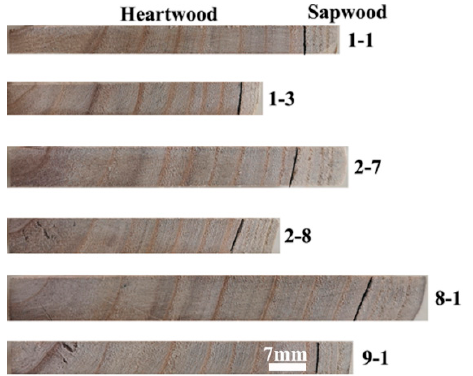
Figure 1. Xylem observations of six C. bungei clones. The cross-sectional surface was photographed under air-dried conditions.